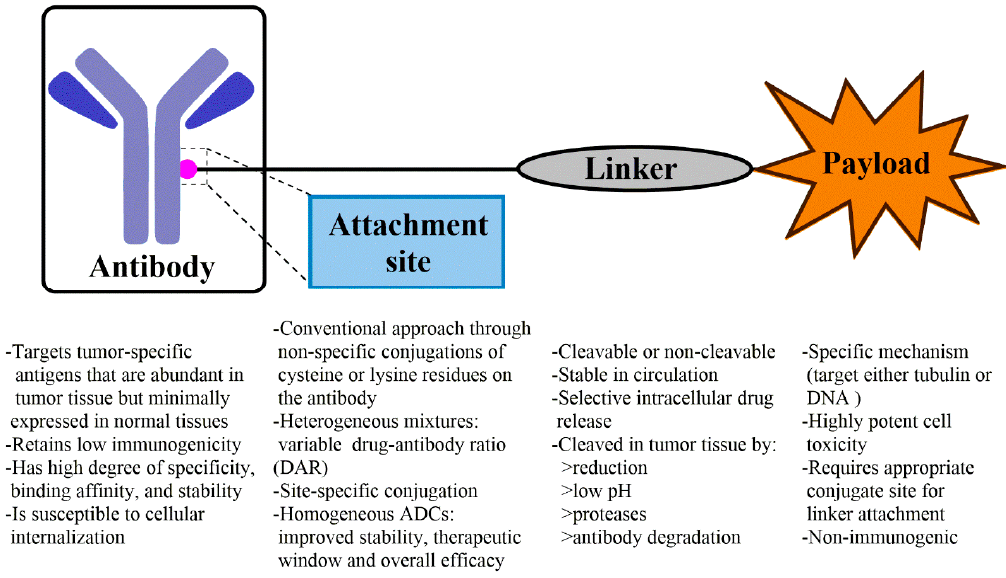
Figure 1. The general components of ADC. Selection principles of antibody, comparison between non-specific and specific conjugations, and descriptions on how the drug is released and its mechanism of action.